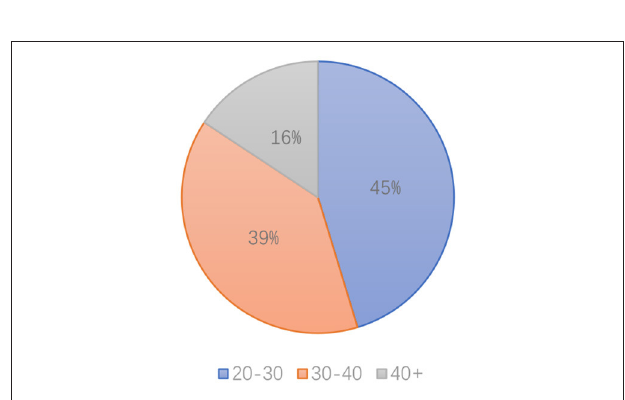
FIGURE 3 | Age of